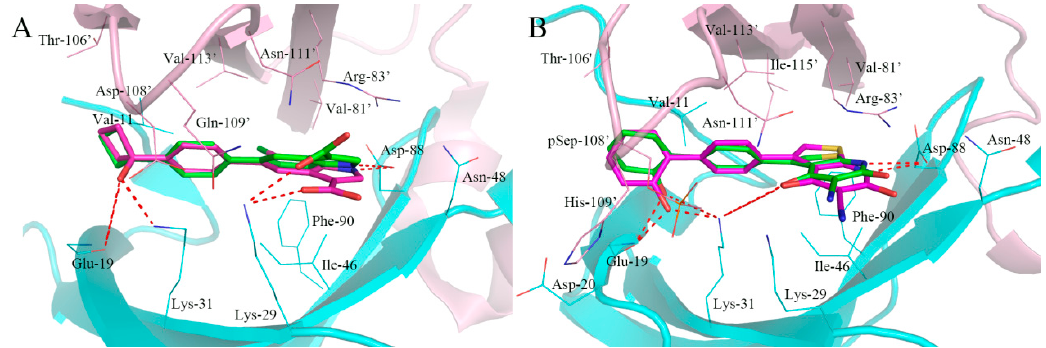
Figure 4. Conformation comparison of the original ligand from X-ray crystal (magenta and stick) and the conformation from Surflex-Dock result (green and stick). ( A ): PF-06409577; ( B ): A-769662. The indole moiety of PF-06409577 and terminal benzene ring of A-769662 generated a little deflection in compared with the original conformation. The hydrogen bond was labeled by red dashed lines.